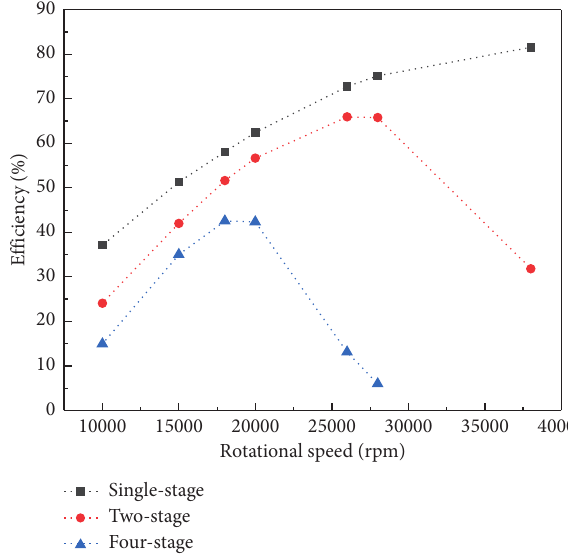
Figure 14: Relationship between output power and rotational speed of small-size turbines.